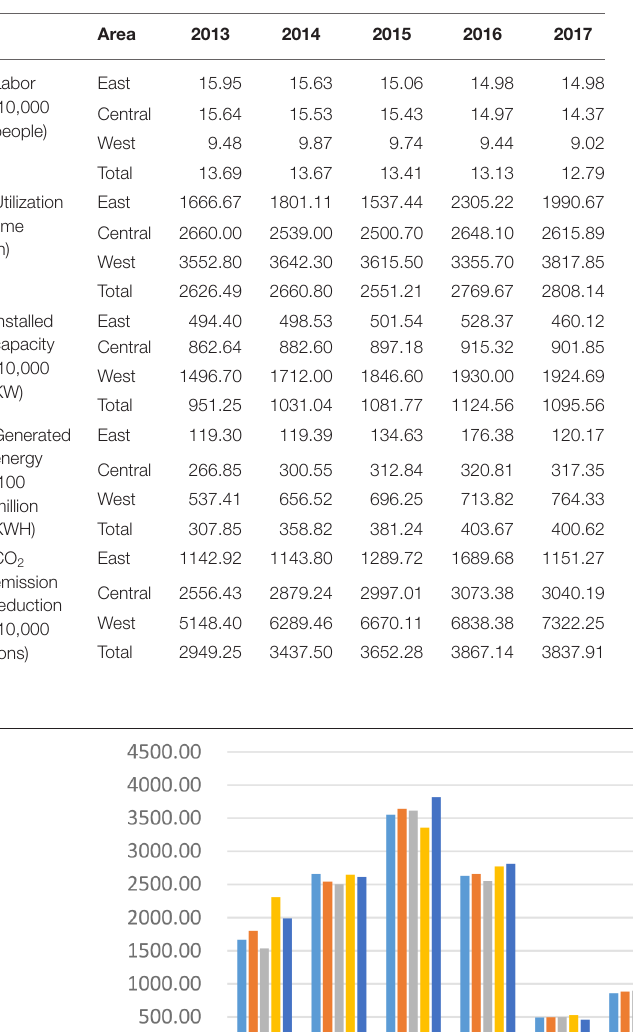
TABLE 2 | Average situation of each indicator by region from 2013 to 2017.